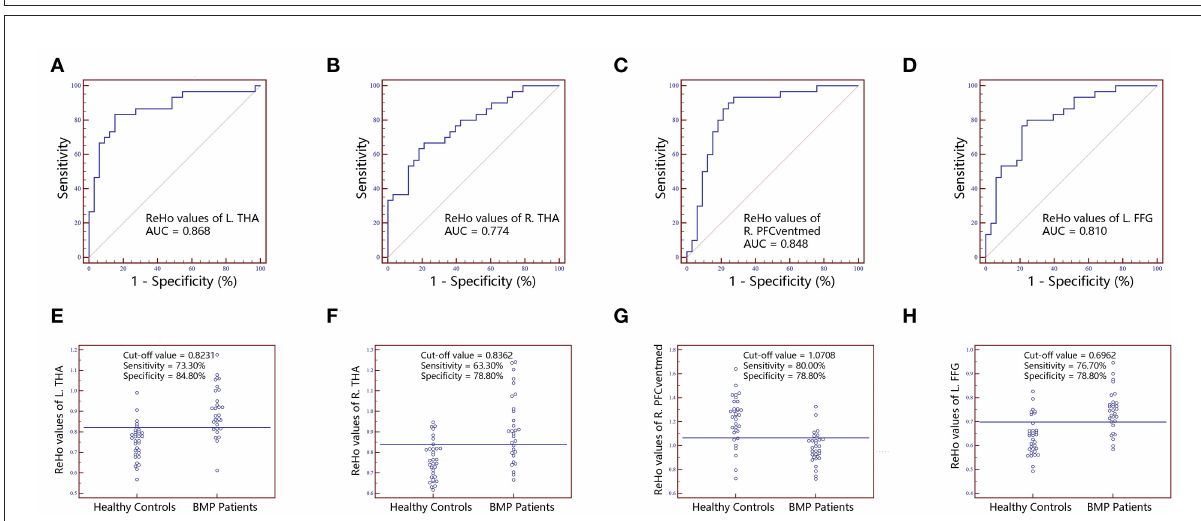
FIGURE4 The classification performance of ReHo values extracted from individual brain regions identified by intergroup comparison. The top row are receiver operating characteristic curves for L.THA (A) , R.THA (B) , R.PFCventmed (C) and L.FFG (D) . The bottom row are interactive dot diagrams for L.THA (E) , R.THA (F) , R.PFCventmed (G) and L.FFG (H) . ReHo, regional homogeneity; AUC, areas under receiver operating characteristic curve; THA, thalamus; PFCventmed, superior frontal gyrus, medial orbital; FFG, fusiform gyrus; R, right; L,